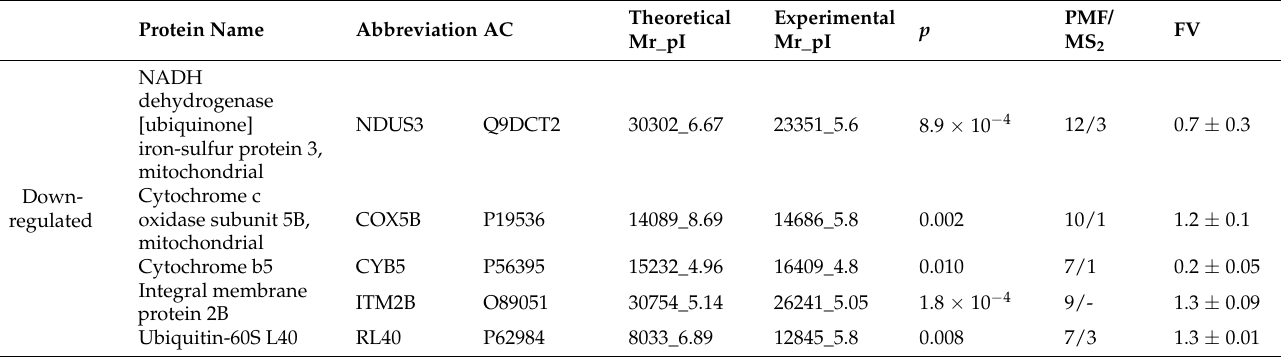
Table 2. MS-identified hippocampal proteins in SAMR1 and SAMP8.